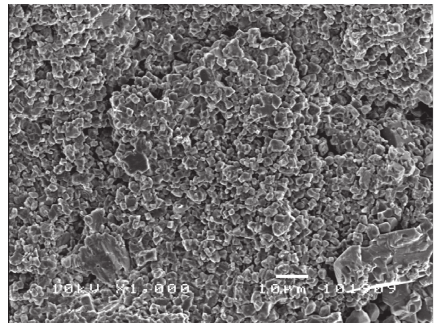
Figure 17: Marble granular fracture, ×